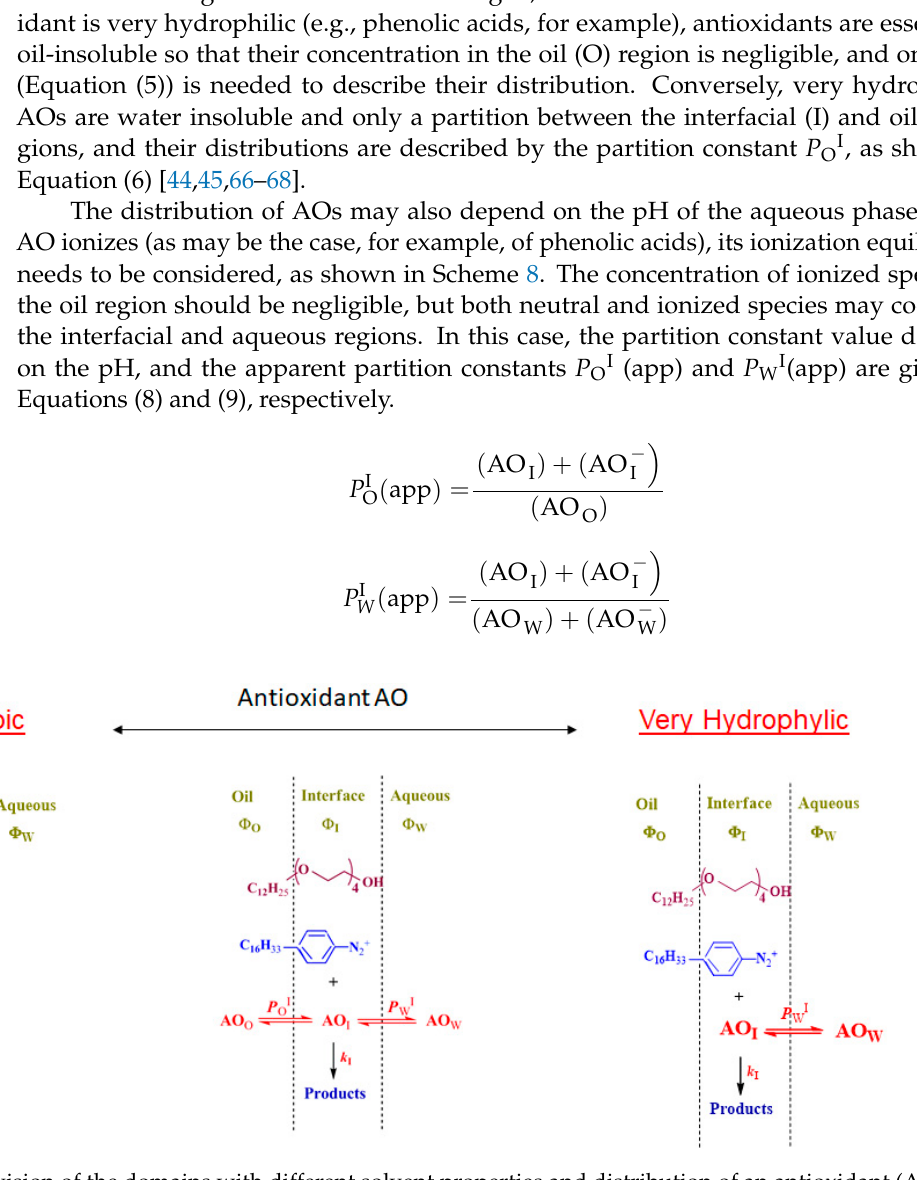
Scheme 7. Conceptual division of the domains with different solvent properties and distribution of an antioxidant (AO) according to their polarity. Reproduced from S. Losada ‐ Barreiro, PhD Thesis, Universidad de Vigo, 2014, with